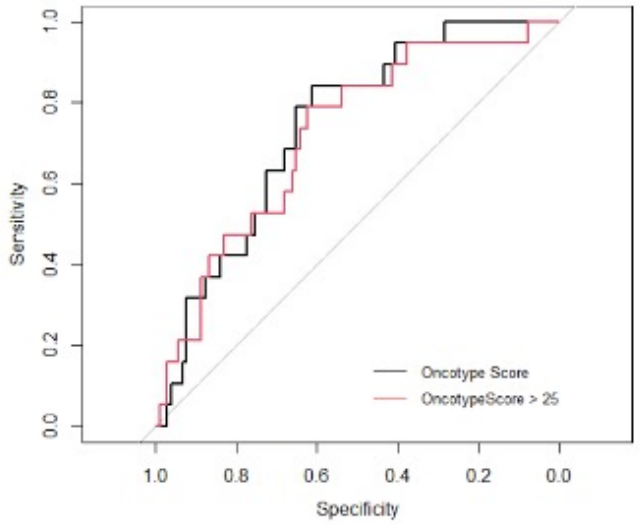
Figure 2. Receiver operating characteristic curve analyses performed to assess the diagnostic test accuracy of the nomogram models for recurrence score as a continuous variable (area under the curve: 0.719) and recurrence score ≤ 25 and >25 (area under the curve: 0.740).